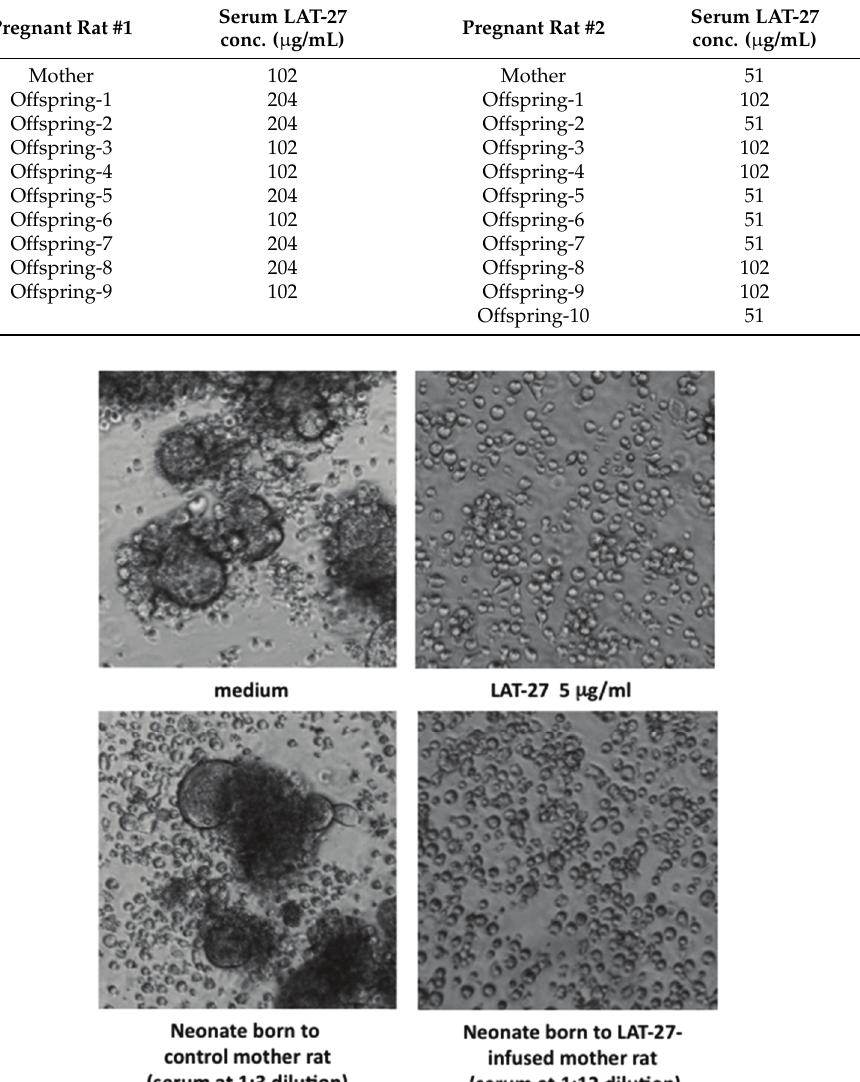
Table 1. Mother-to-offspring transfer of LAT-27 in rats. Two pregnant SD rats were infused i.p. with 25 mg/head LAT-27 two times on − 7 d and − 2 d delivery. Two days after delivery, LAT-27 concentration of each serum was quantitated by ELISA.